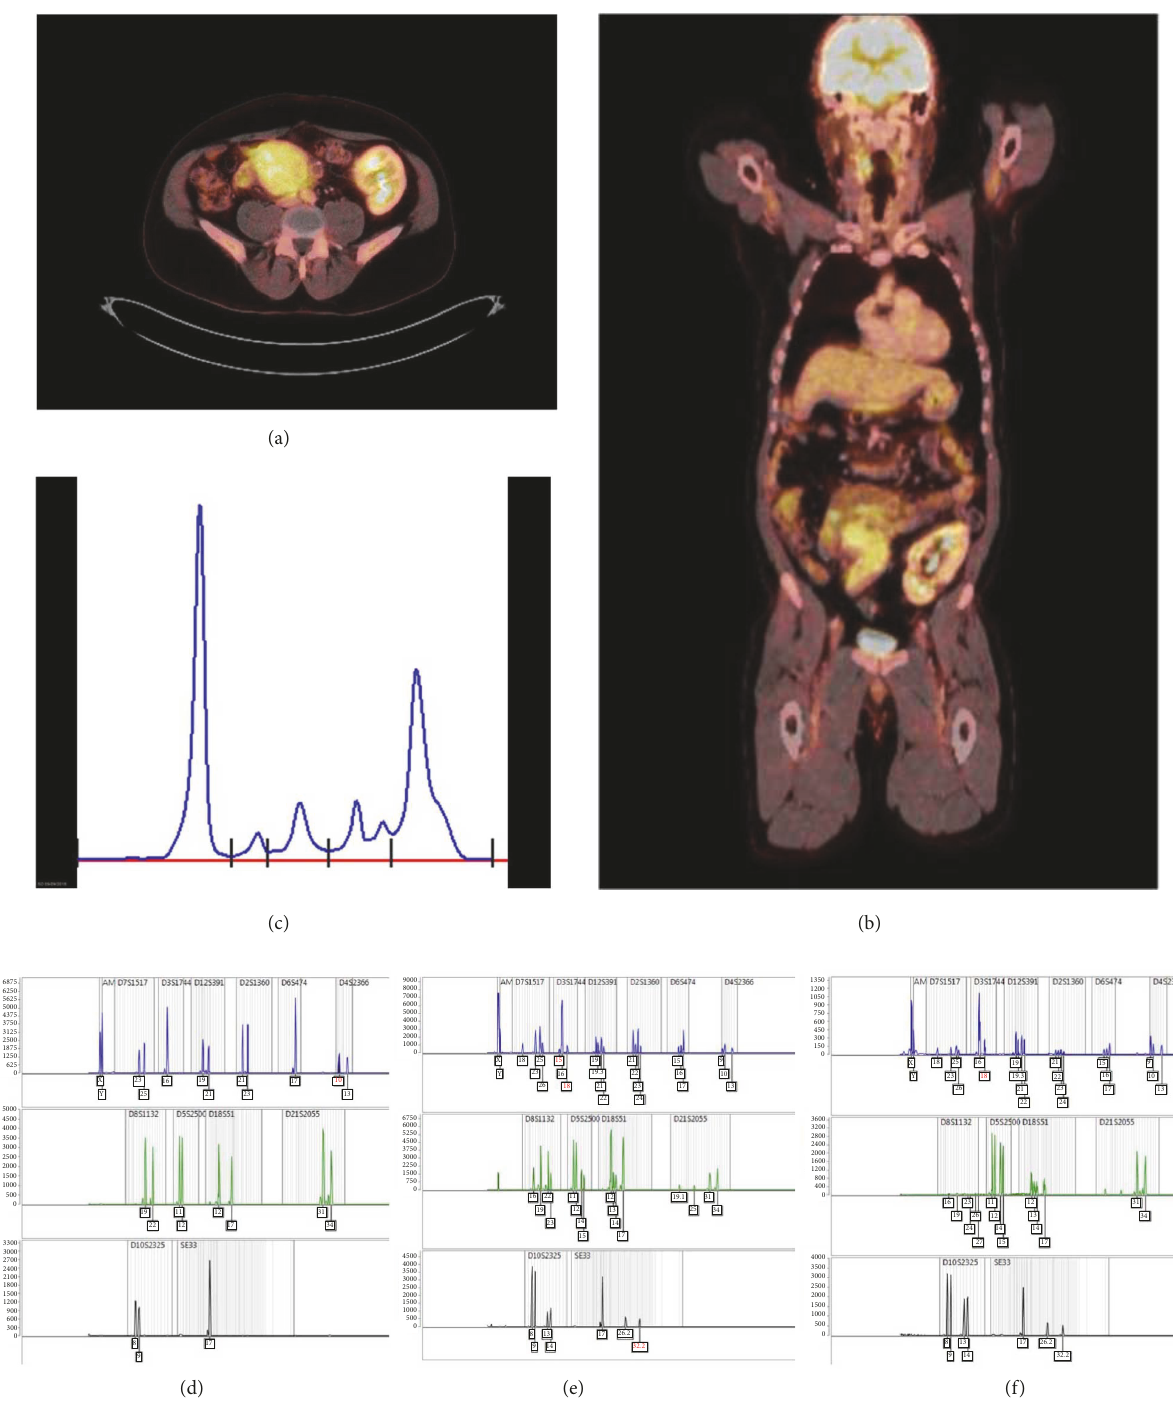
Figure 2: PET/CT scan (a) and (b) : diffuse uptake of FDG and enlargement of pancreas allograft (arrow), without focal lesions. Normal captions of bone marrow, brain, and kidney (arrow heads); (c) serum proteinogram : typical M protein gamma peak; (d) microsatellite analysis (Mentype (cid:2) Chimera (cid:2) ): DNA from recipient peripheral blood (leukocytes). (e-f) Mixed donor and recipient microsatellite analysis was observed in the DNA extracted from the paraffin block obtained from selected areas with a high infiltration of plasma